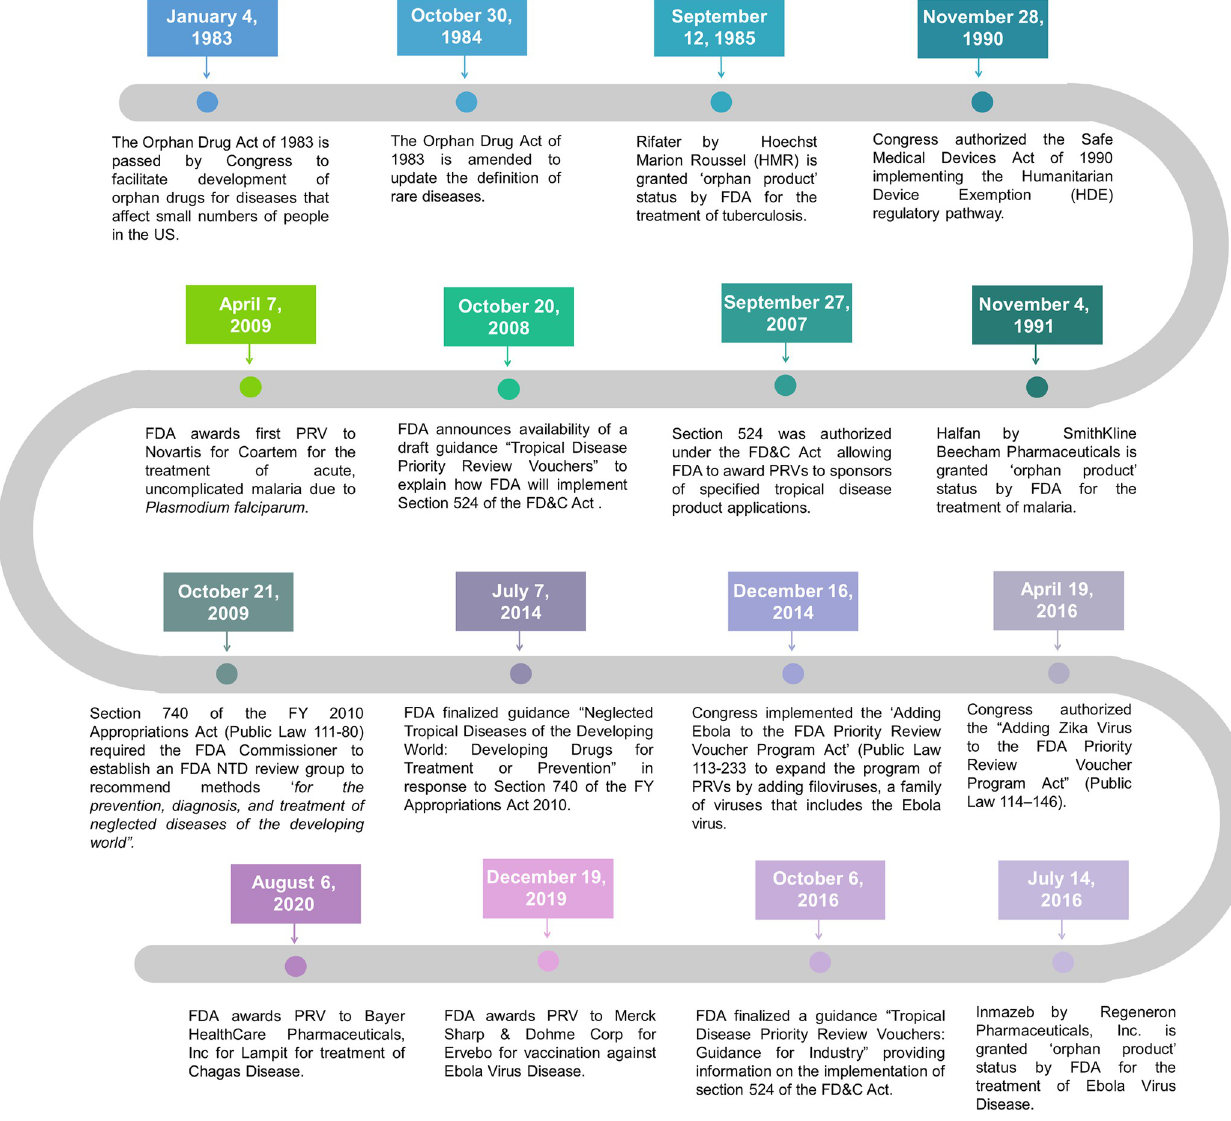
Fig 1. Key milestones in the US FDA’s role to combat NTDs. AU : AbbreviationlistshavebeencompiledforthoseusedinFigs 1 (cid:0) 4 andTables 1 and 2 : Pleaseverifythatallentriesarecorrect : Information to create this figure was adapted from FDA websites, FDA databases and approval packages and the Library of Congress Public Laws. FDA, Food and Drug Administration; FD&C, Federal Food, Drug, and Cosmetic; HDE, Humanitarian Device Exemption; NTD, neglected tropical disease; PRV, priority review